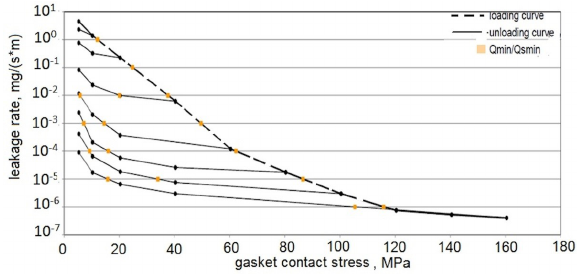
Where: F Q – is a hydrostatic force resulting from fluid pressure. Each parameter indexed as 1 means in service state, whereas parameters indexed as 0 means in operating state.